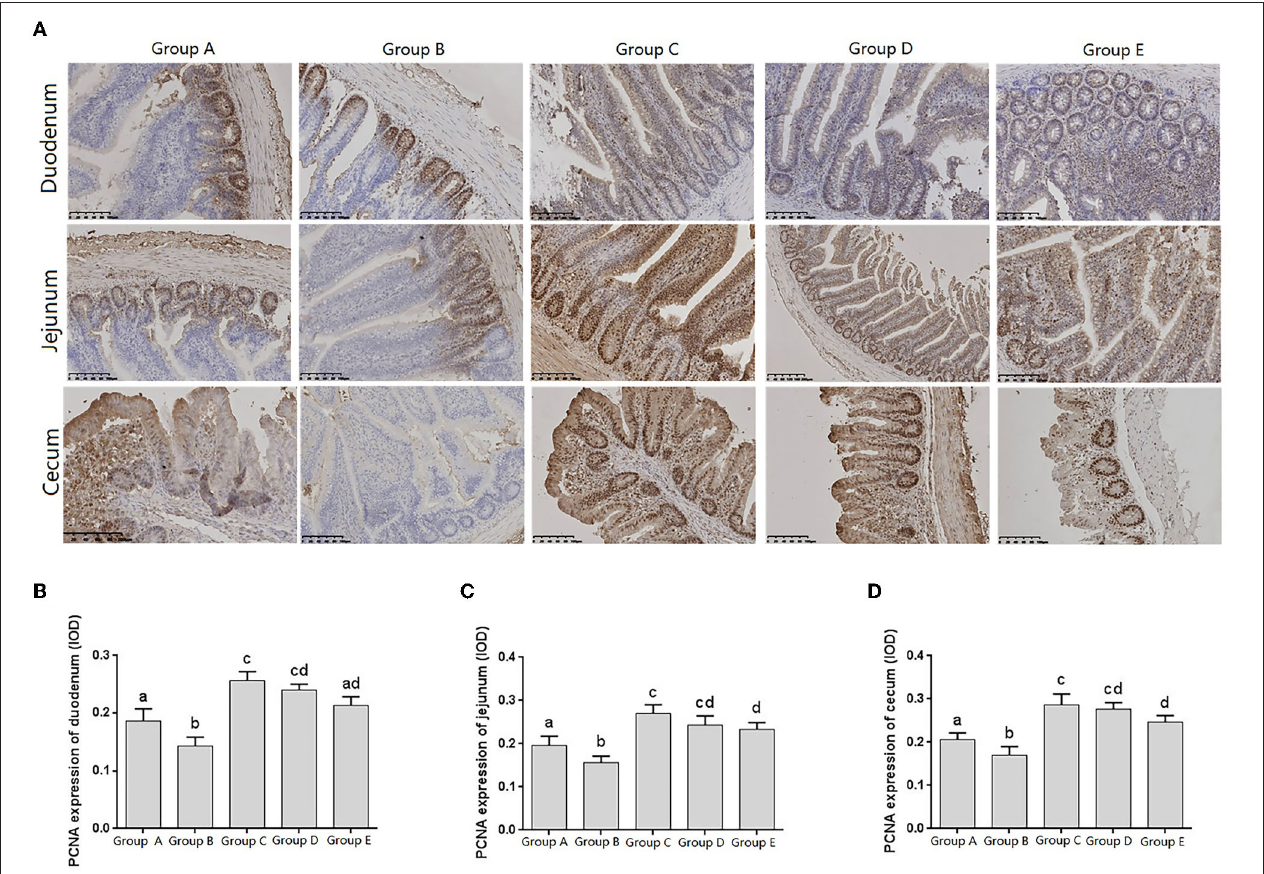
FIGURE 5 | Changes of PCNA distribution in intestine of chicks after different treatments. (A) Immunohistochemistry (IHC) staining of the distribution of PCNA in different treatment groups. (B–D) Levels of PCNA in different treatment groups. Group A, control group; Group B, infection group; Group C, JYBR-190 pre-fed group; Group D, JYBR-190 fed group; Group E, antibiotic group. Data are expressed as mean ± standard deviation (SD). Different lowercase letters on the columns indicate significant differences ( P < 0.05); the same lowercase letters indicate no significant difference ( P > 0.05).